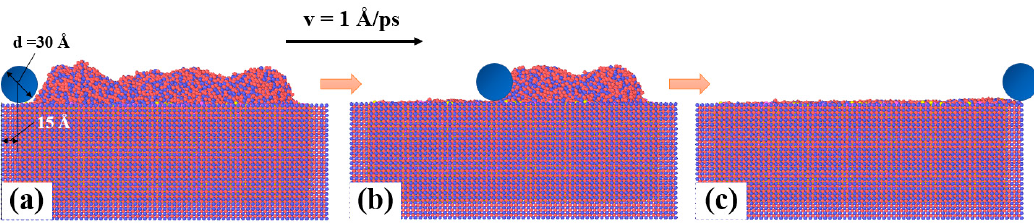
Figure 2. Powder spreading process: ( a – c ) the beginning stage, the state at 70 ps, and the end stage, respectively.